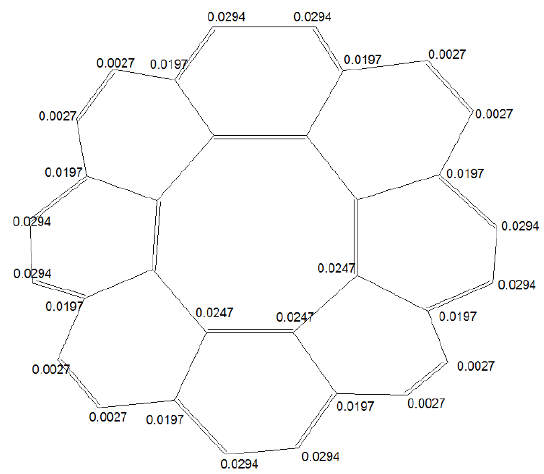
Figure 5. Fukui function (for an electrophilic attack, f + ) in circulene 1b (B3LYP/6-311G(d,p).